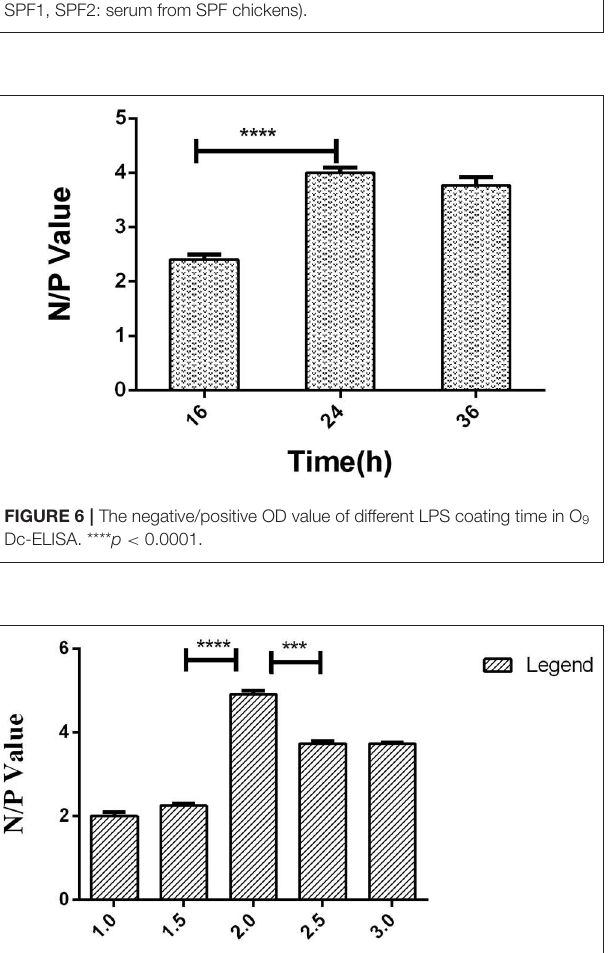
FIGURE 4 | Concentration optimization of HRP-labeled O 9 McAb in O 9 Dc-ELISA.